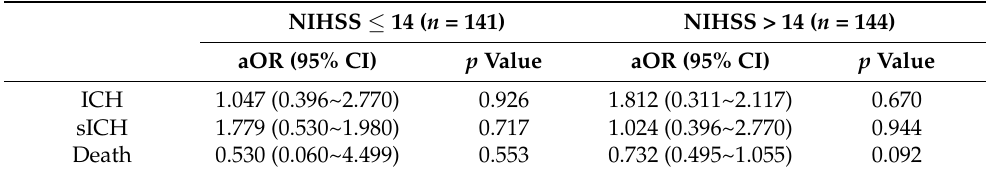
Table 3. Multivariate regression analysis of safety outcome in subgroups according to